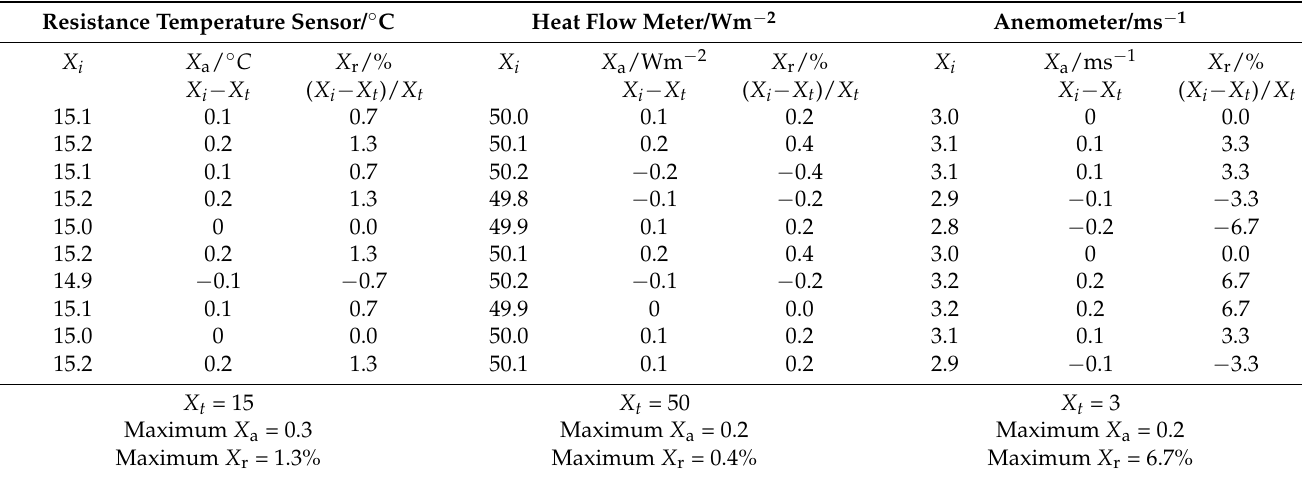
Table 4. Error calculation